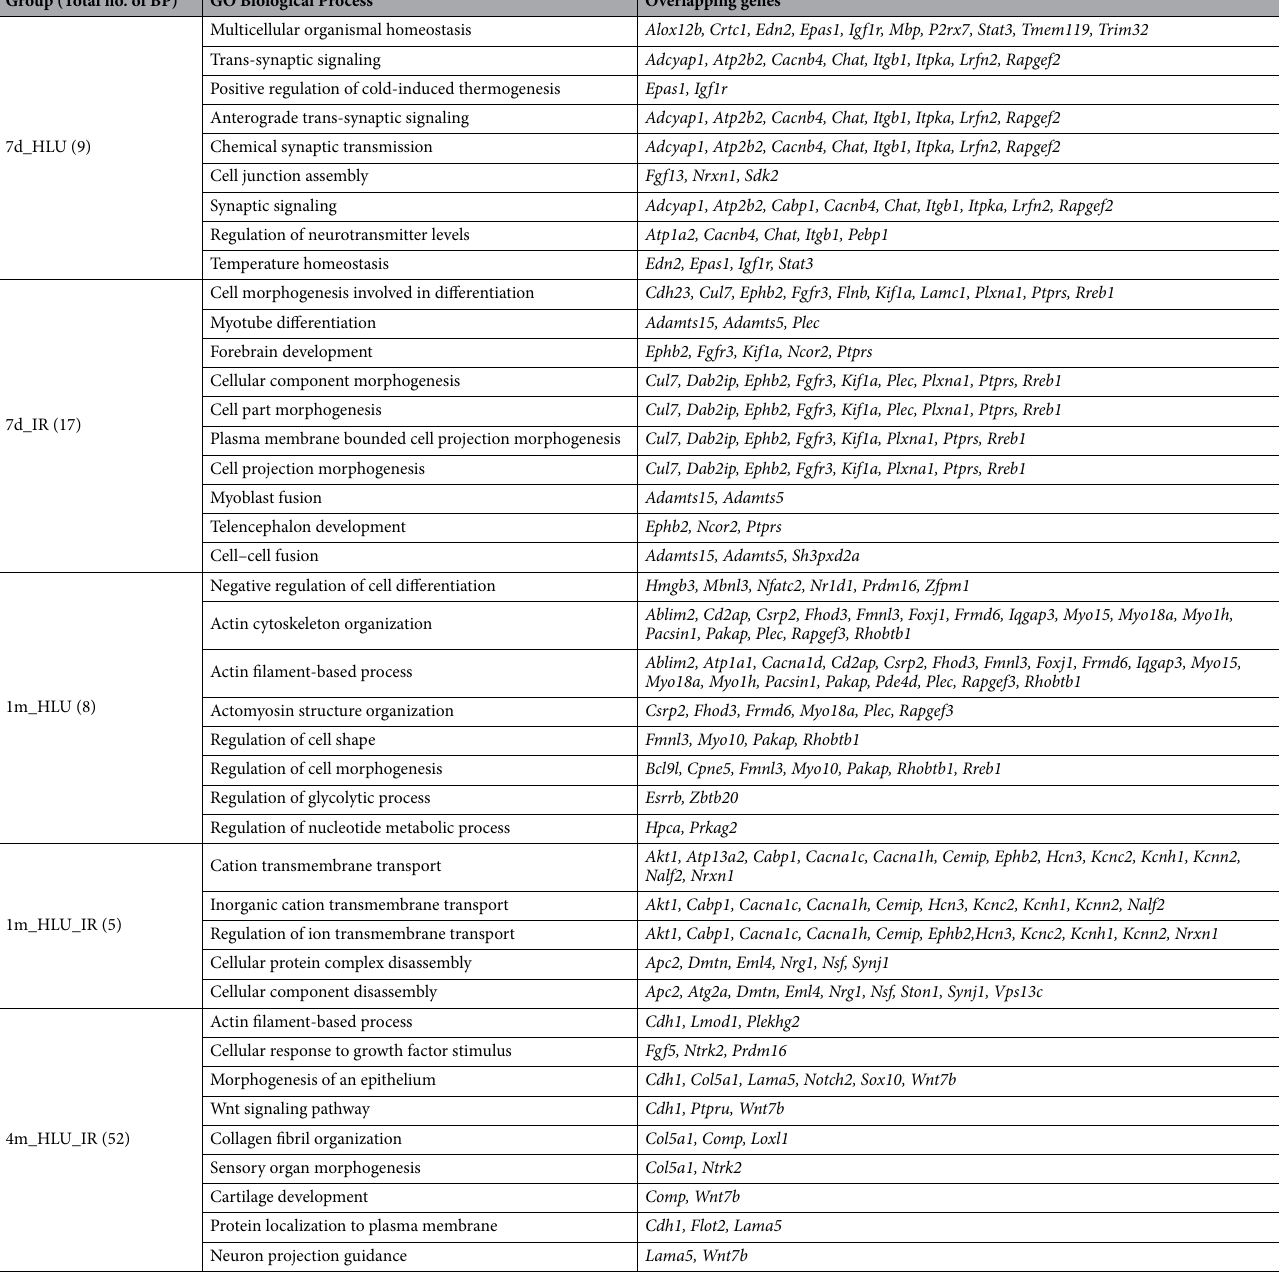
Table 4. GO biological processes and related genes common between RNA-Seq and methylation. Top ten BP (or lower if there are < 10 processes) enriched in a given group based on both, differential expression and differential methylation, are listed. The total number of BP for each group, and constituent genes that overlap for a given BP are also included. Full list of BP, constituent genes, and associated methylation difference and fold change values are included in Supplementary Table S7. BP biological process, HLU hindlimb unloading, IR